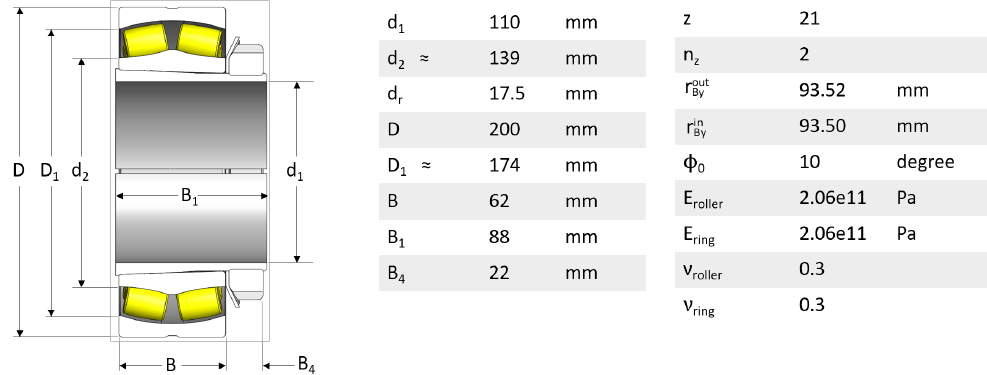
Figure 2. Spherical roller bearing SKF 23124 CCK/W33 with conical adapter sleeve H 3124. Both rows contain 21 roller elements.